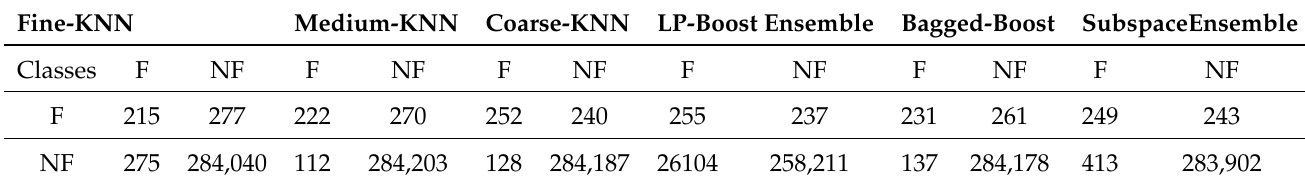
Table 8. Confusion matrix of 10-fold classification methods on transformed